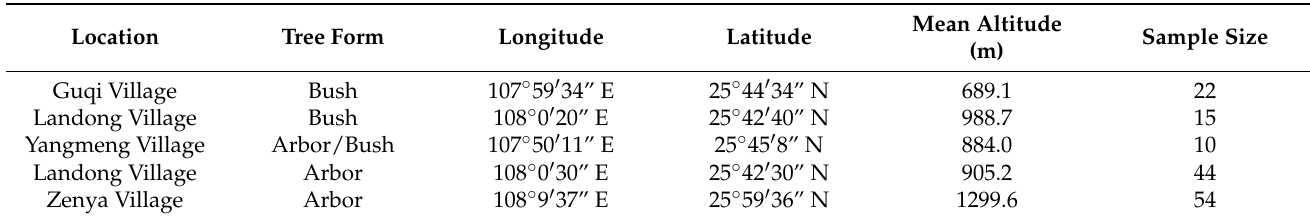
Table 1. List of studied populations of ancient tea plant germplasm used for genetic and phenotypic analysis, as well as their geographical information.